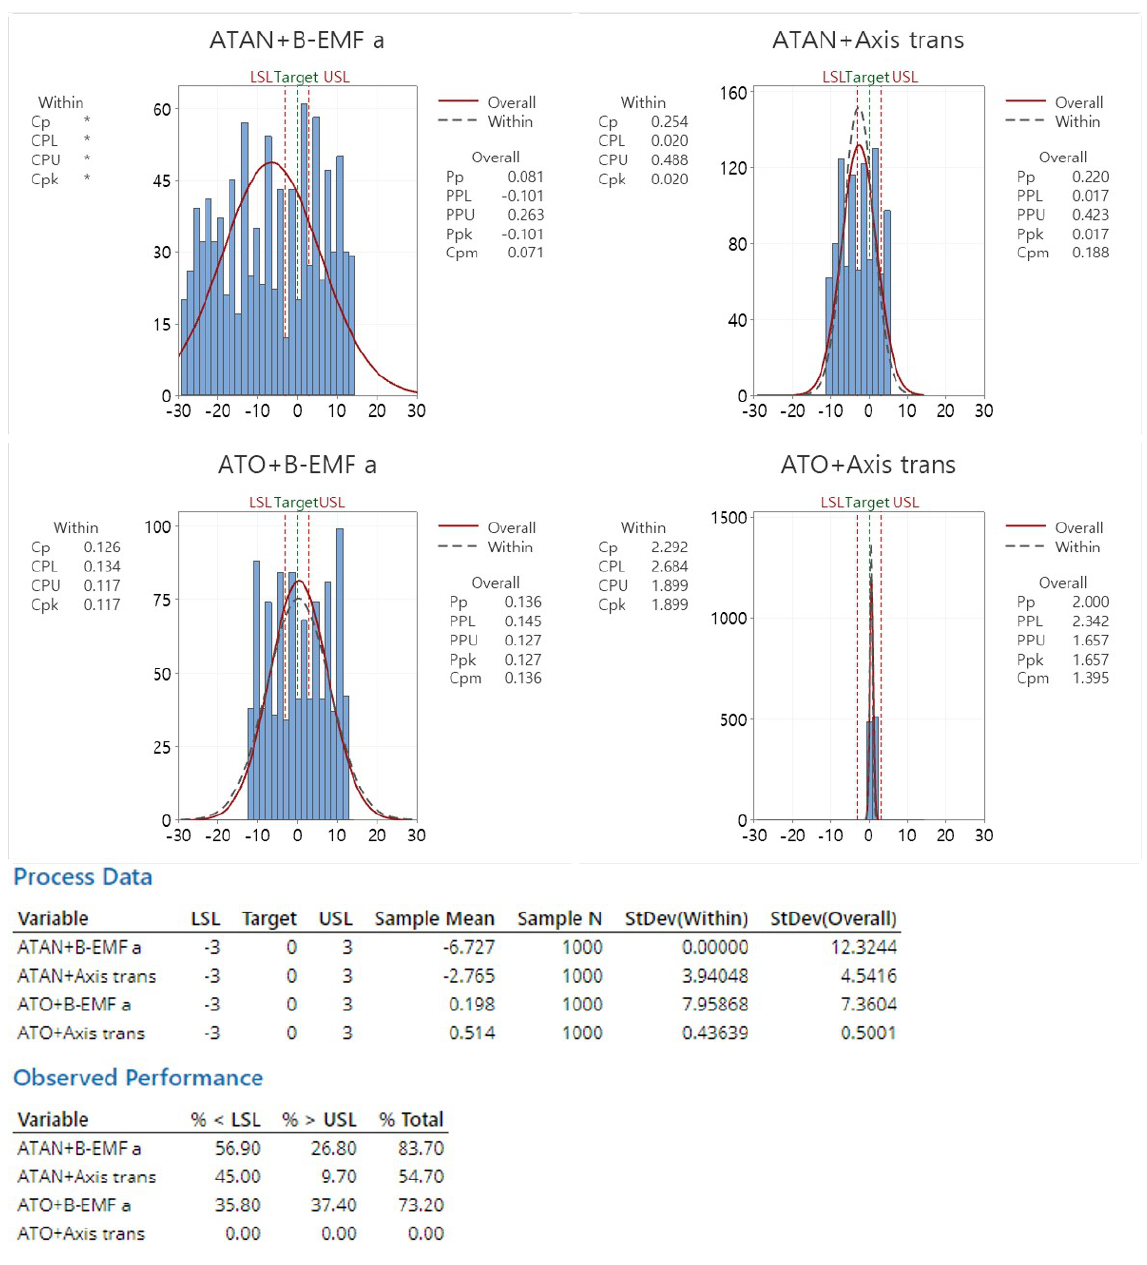
Figure 13. Overall normal distribution and capability